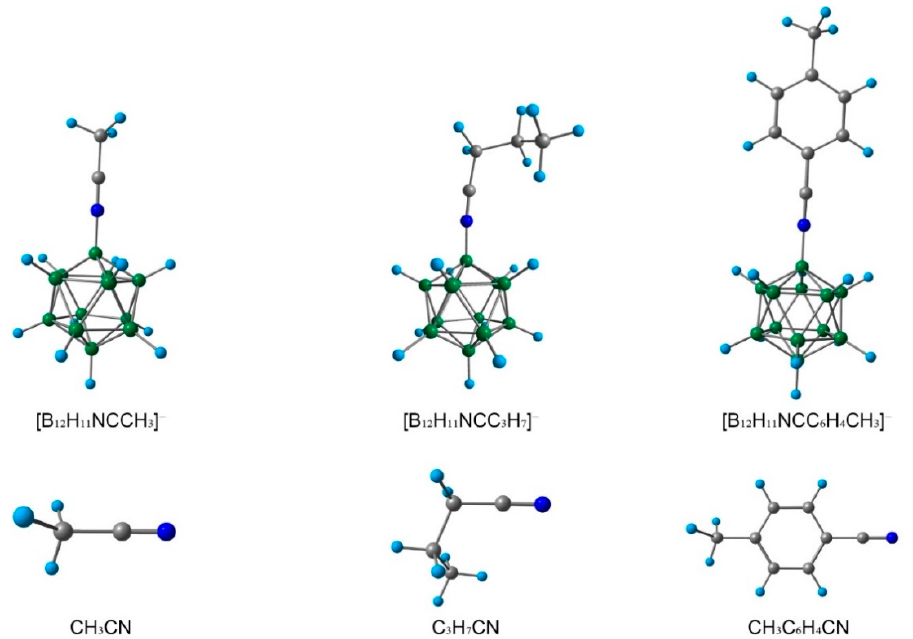
Figure 4. Optimised structure of nitriles RCN, R = CH 3 , n -C 3 H 7 , CH 3 C 6 H 4 and nitrilium derivatives [B 12 H 11 NCR] − , R = CH 3 , n -C 3 H 7 , CH 3 C 6 H 4 .